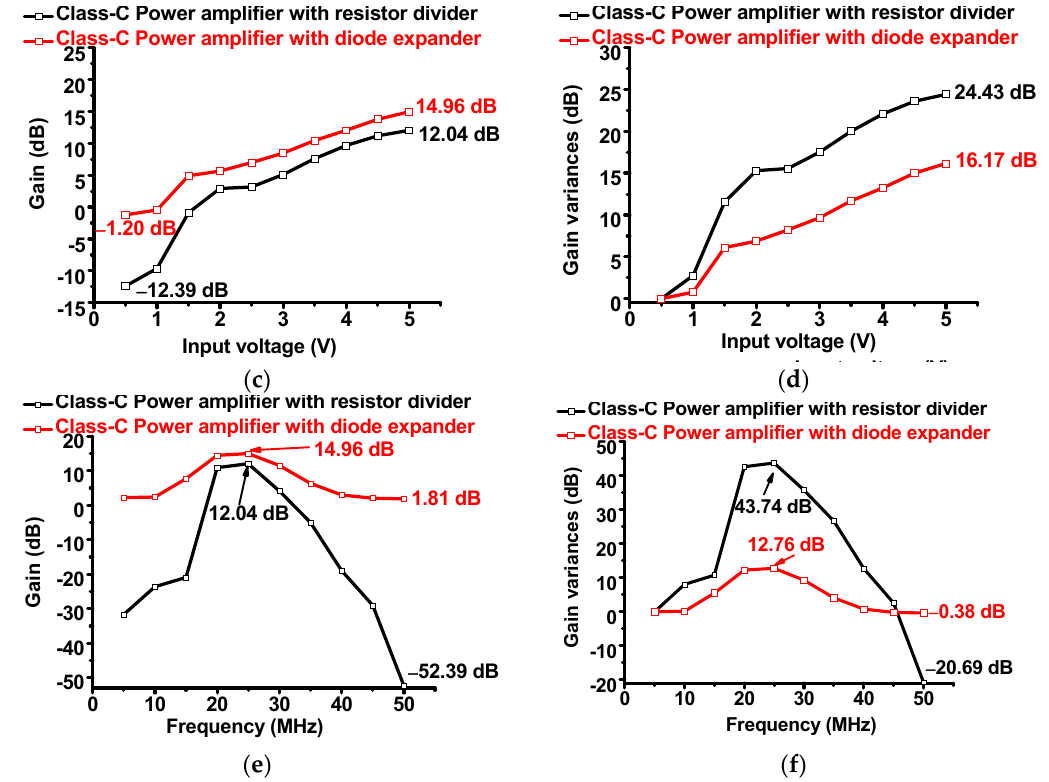
Figure 5. ( a ) Measurement setup sketch and ( b ) an image of its actual realization for measurement of voltage gain and DC current consumption of the power amplifiers; measured voltage gain of the class-C power amplifier versus input voltage with the ( c ) resistor divider and diode expander architecture; ( d ) measured voltage gain deviation of the class-C power amplifier versus input voltage with resistor divider and diode expander architecture; measured voltage gain of the class-C power amplifier versus frequency with the ( e ) resistor divider and ( f ) diode expander architecture.